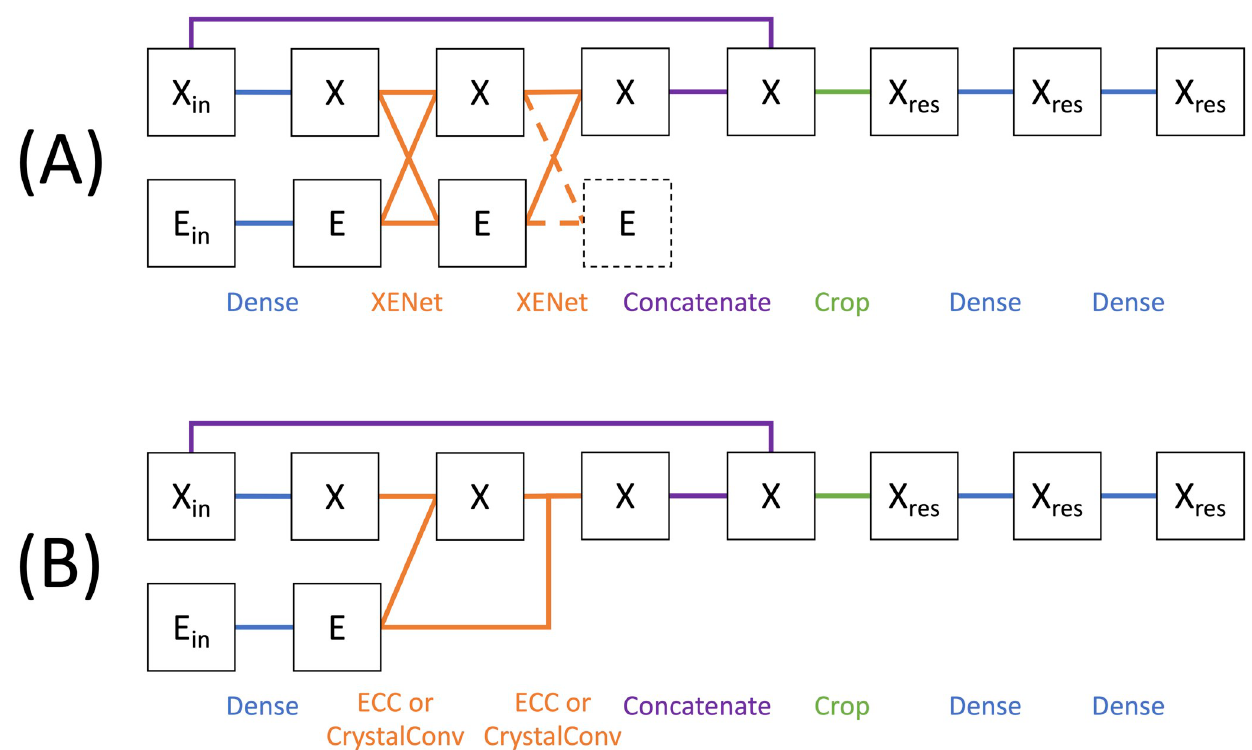
Fig 1. Schematic representation of FixbbGCNs, the networks used in our experiments. (A) Example layout for a model with two XENet layers. X denotes node attribute tensor with X in as the input tensor and X res as the single-node subset of the X tensor which represents the protein residue of interest. E denotes the edge attribute tensor with E in as the input tensor. Dotted lines are used to represent operations that are omitted as described in the main text. (B) Example layout for a model with two ECC or CrystalConv layers using the same notation. The A tensor is omitted from this diagram because it never changes.